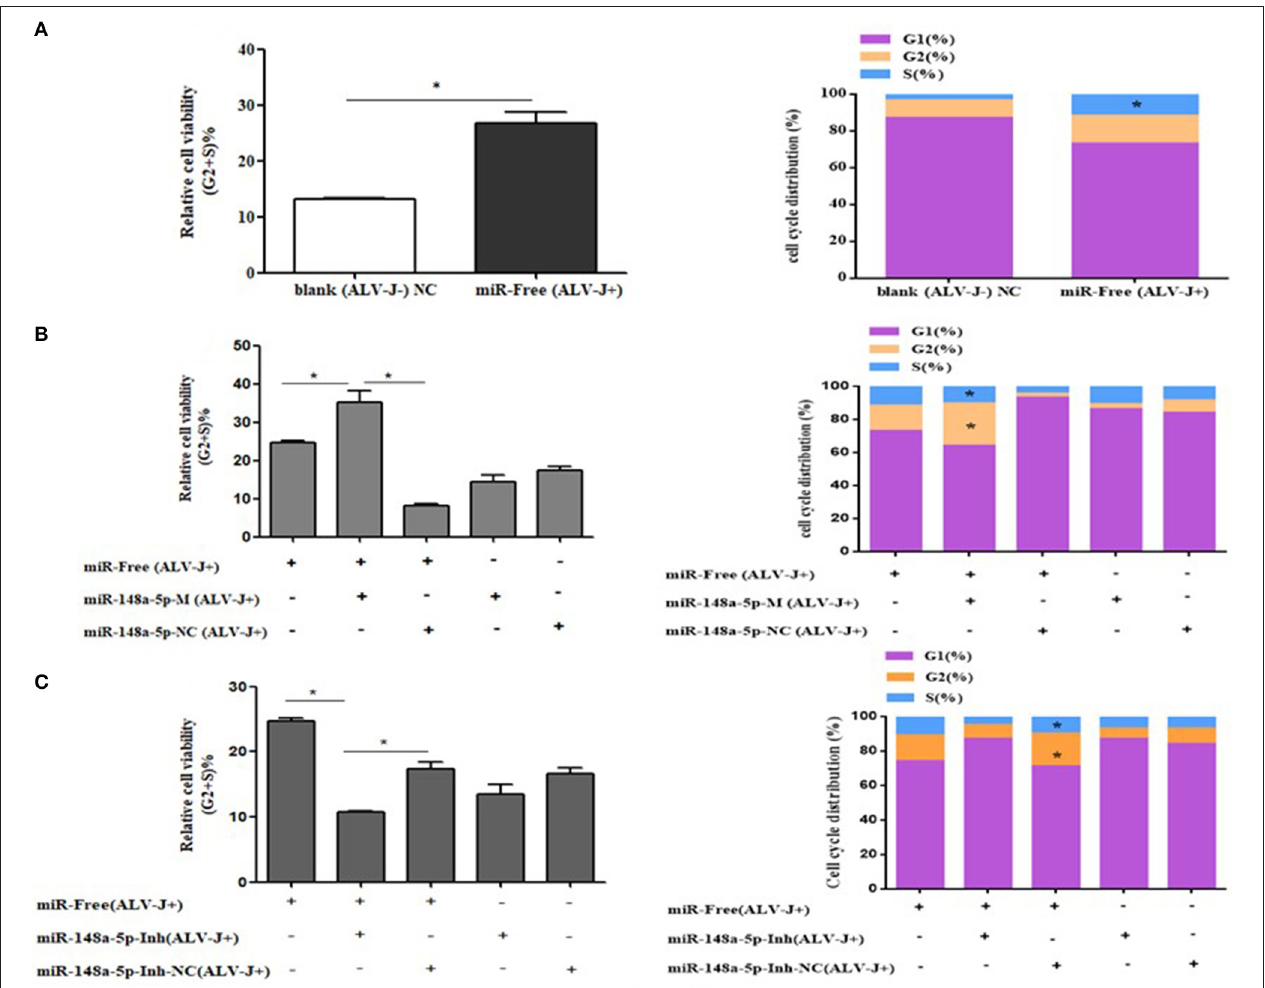
FIGURE 8 | Cycle procession of ALV-J-infected CEF cells was affected by gga-miR-148a-5p. (A) Cell cycle was promoted with ALV-J-infected cells. (B) Cell cycle was dramatically promoted with gga-miR-148a-5p overexpression. (C) Cell cycle was suppressed by gga-miR-148a-5p inhibitor. Values are mean means ± SEM. * P <